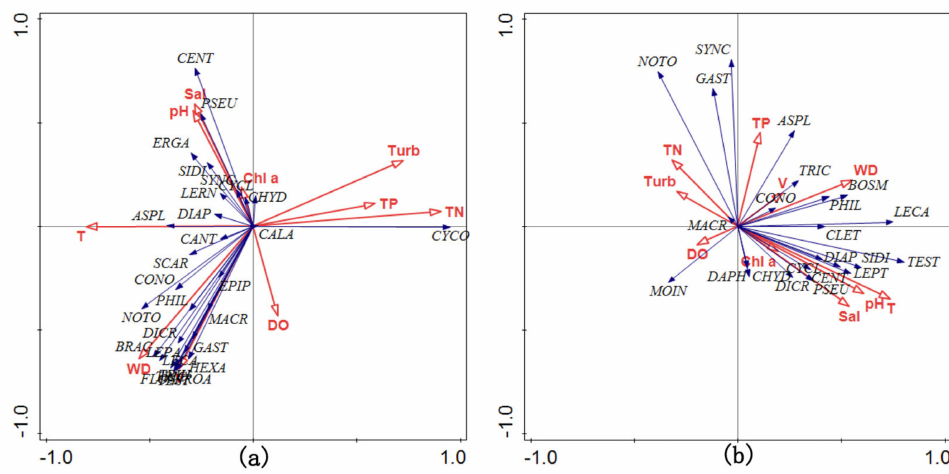
Figure 8. RDA of zooplankton family composition with environmental factors. ( a ) MBC; ( b )